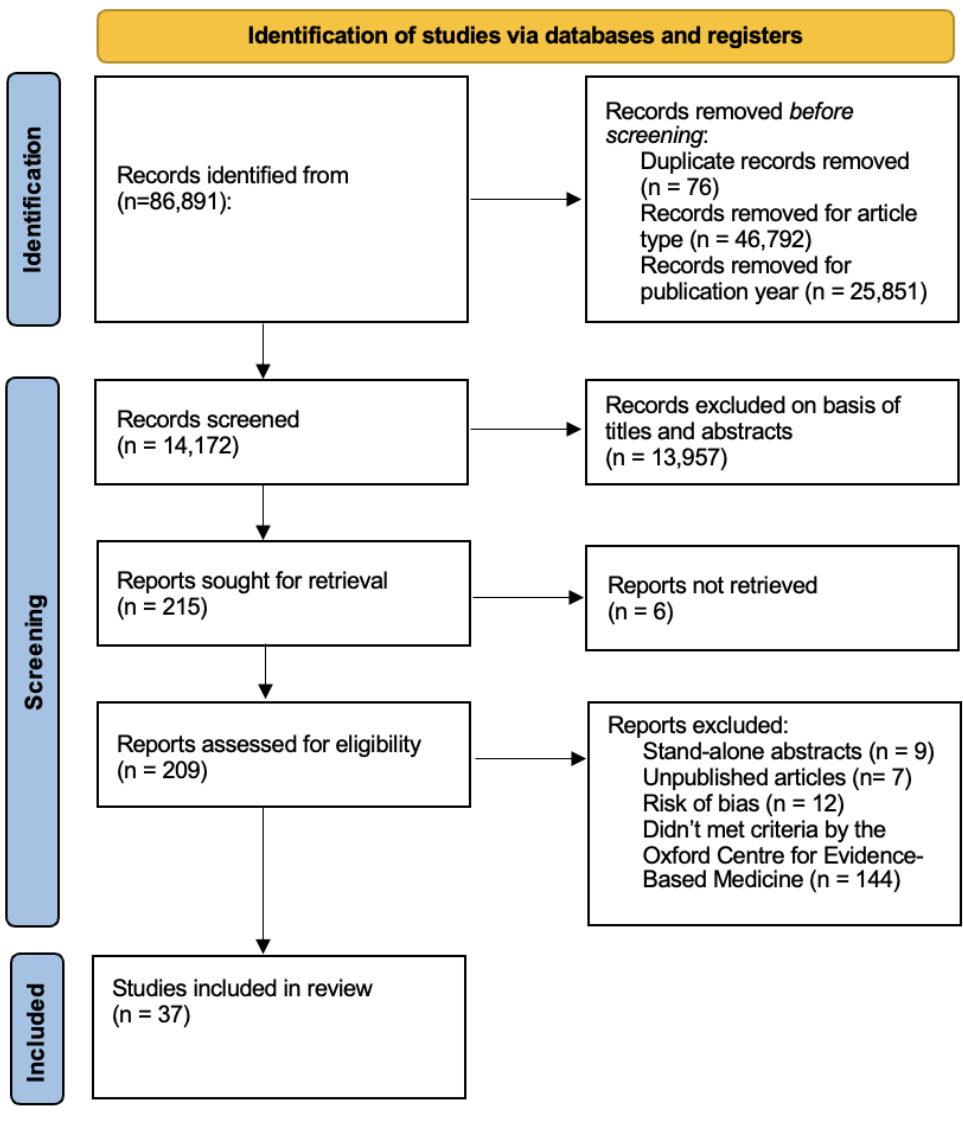
Figure 1. Method Figure 1. Method flow-chart.